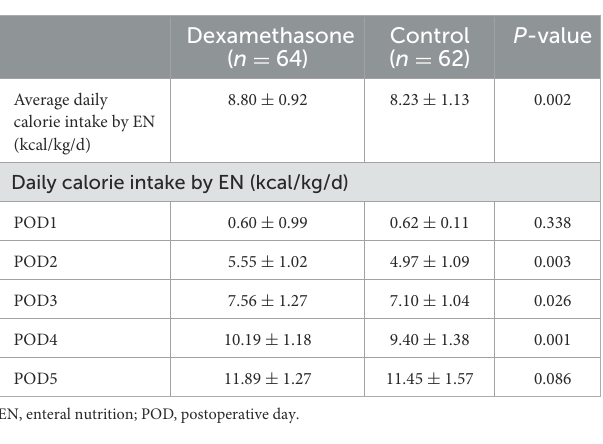
TABLE 1 Baseline characteristics of participants enrolled in the study. TABLE 2 Postoperative caloric tolerance of enteral nutrition.